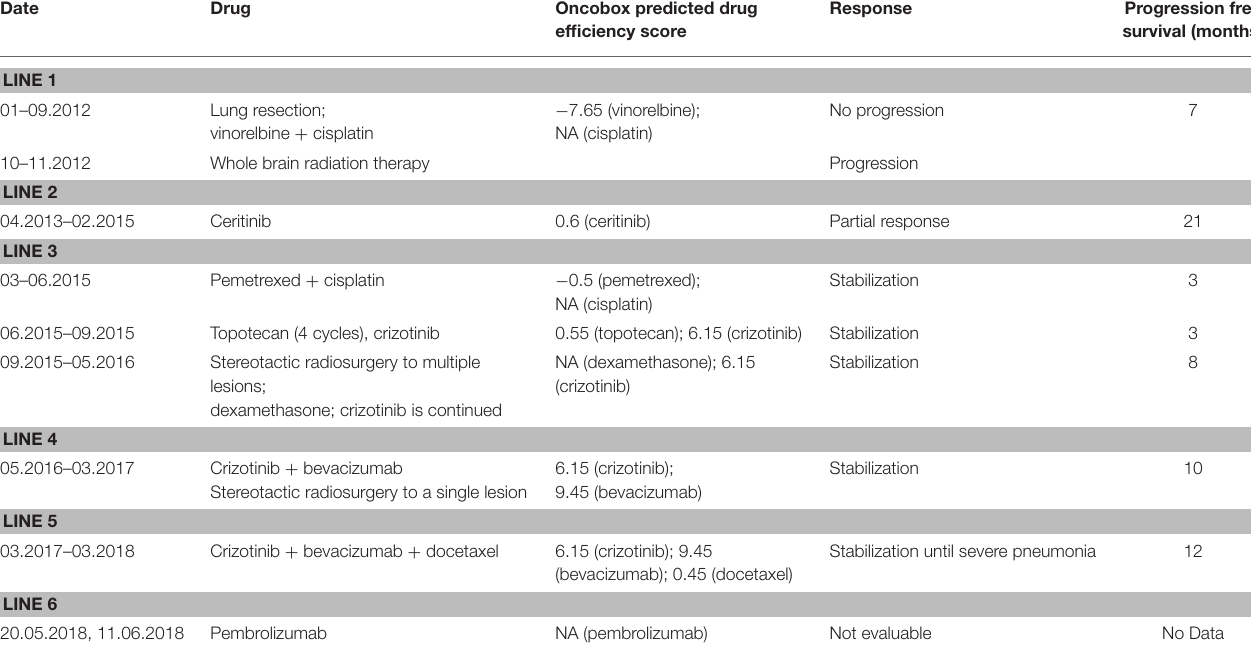
TABLE 2 | Outline of the patient treatment